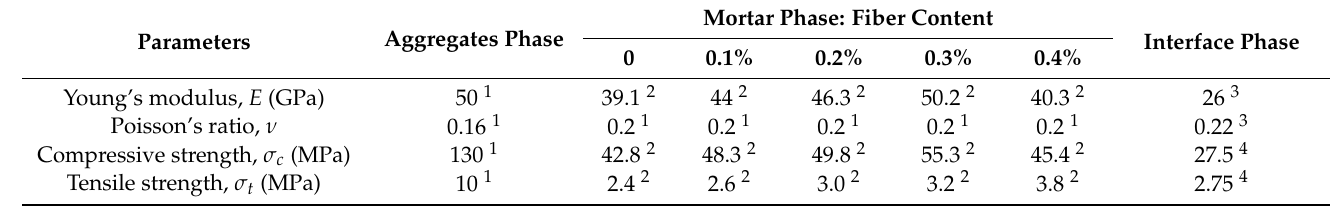
Table 12. Mesoscale each components mechanical parameters of hybrid fiber-reinforced LHPCC.